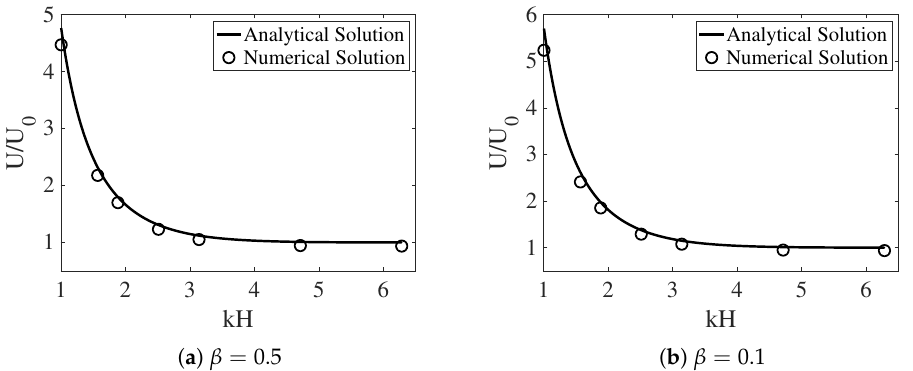
Figure 3. The scaled swimming speed vs. the nondimensional interface height kH for different β . The fluid interfaces are non-deformable. The analytical solutions are from